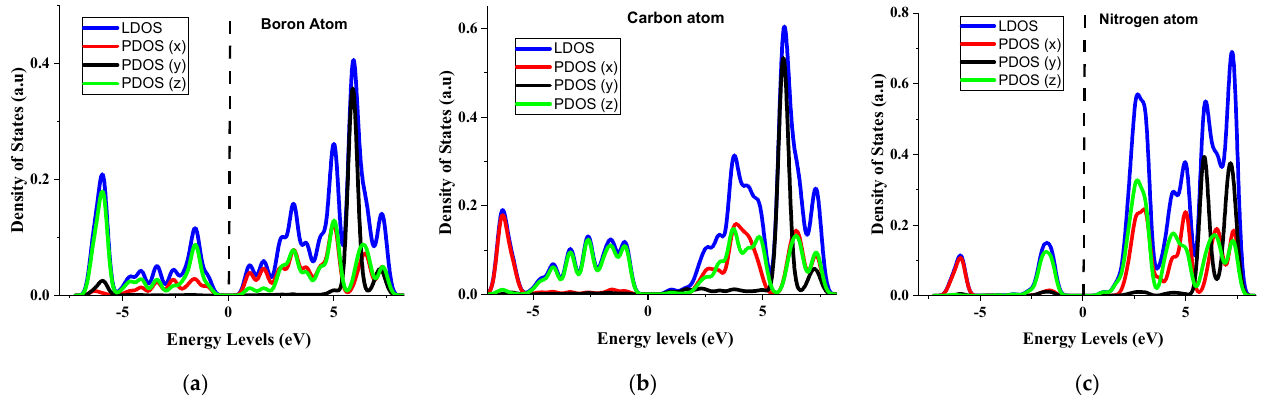
Figure 4. PDOS of (5, 5) CBNNT system under GGA-PBE. ( a ) Boron atom ( b ) carbon atom ( c ) Ni- trogen atom.